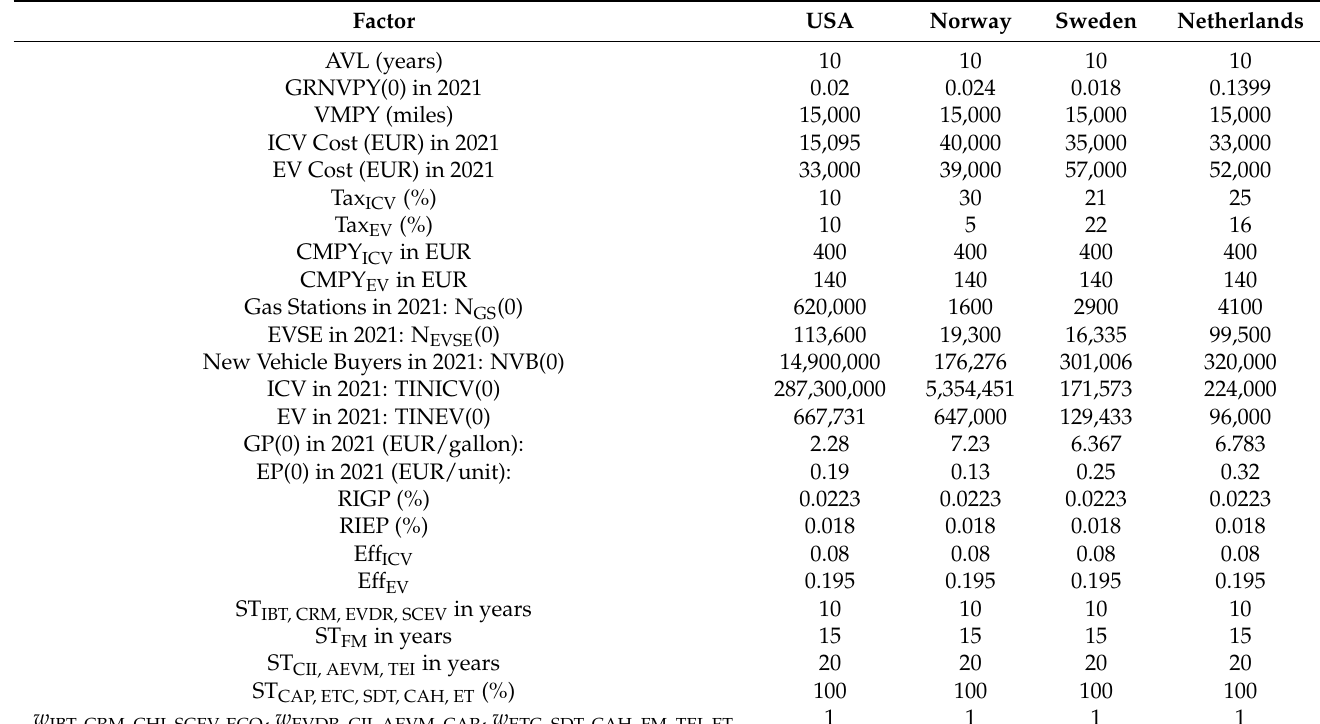
Table 4. Values across different